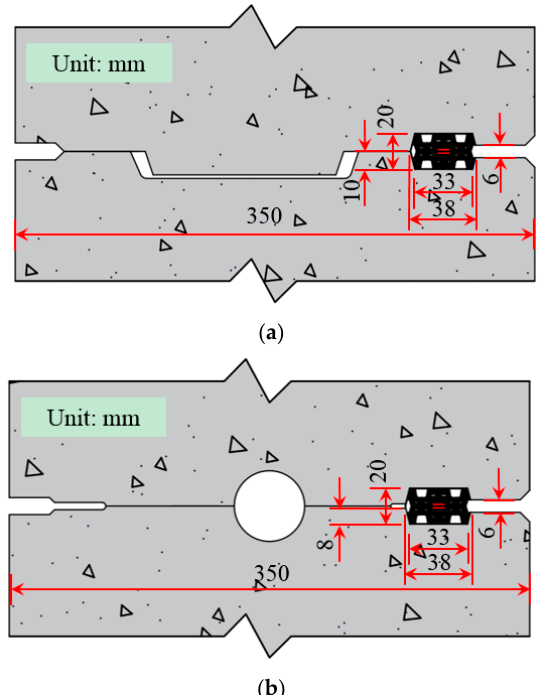
Figure 2. Circumferential and longitudinal joint. ( a ) Circumferential joint. ( b ) Longitudinal